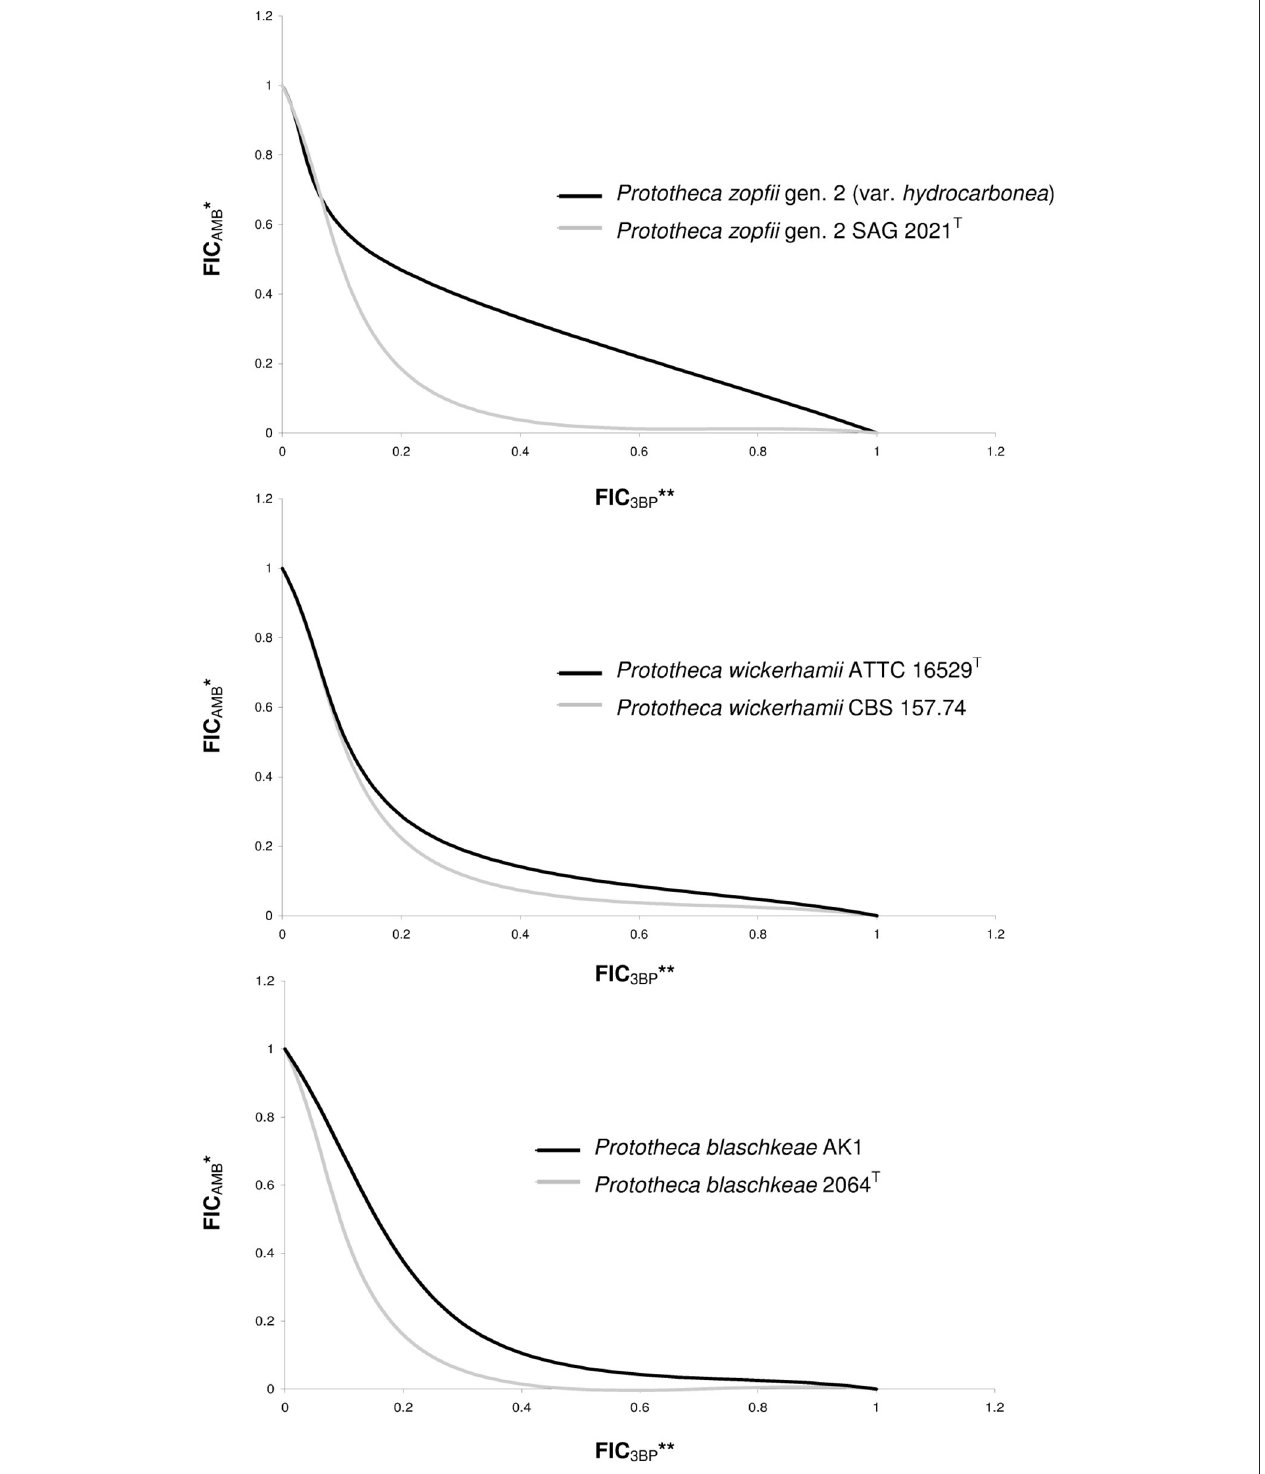
FIGURE 3 | Isobolograms showing synergistic or additive types of interactions between AMB and 3BP. *FIC AMB , Fractional Inhibitory Concentration of AMB, defined as the ratio of the MIC of AMB in association with 3BP to the MIC of AMB tested alone; **FIC 3BP, Fractional Inhibitory Concentration of 3BP, defined as the ratio of the MIC of 3BP in association with AMB to the MIC of 3BP tested alone; FIC values determined based on 2D checkerboard assay.